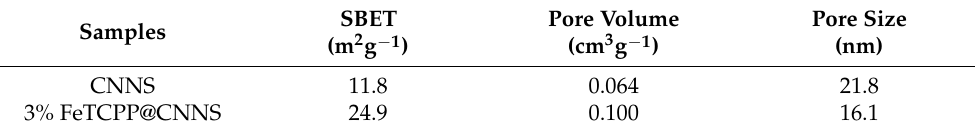
Figure 6. N 2 adsorption–desorption isotherms curves of CNNS and 3% FeTCPP@CNNS. Table 1. Specific surface, pore characteristics, and crystallite sizes of the as-prepared samples.